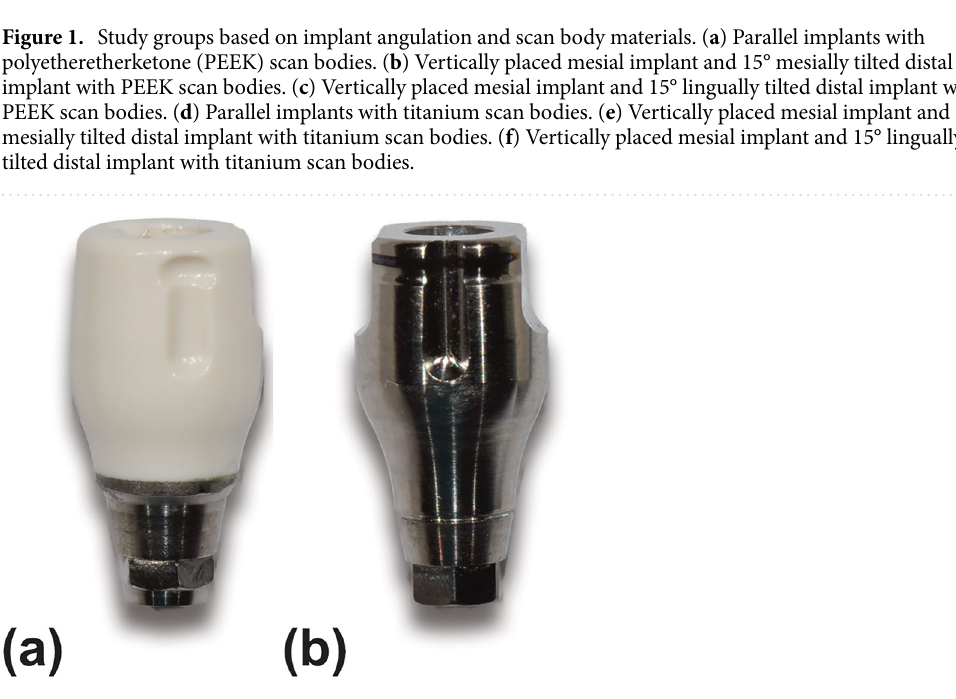
Figure 2. Scan bodies used in this study. ( a ) Polyetheretherketone scan body. ( b ) Titanium scan